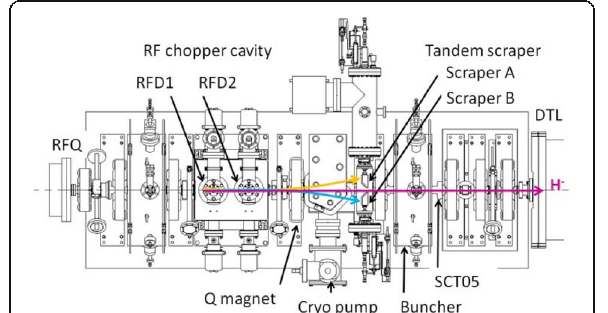
Fig. 5 Chopper system in the J-PARC linac